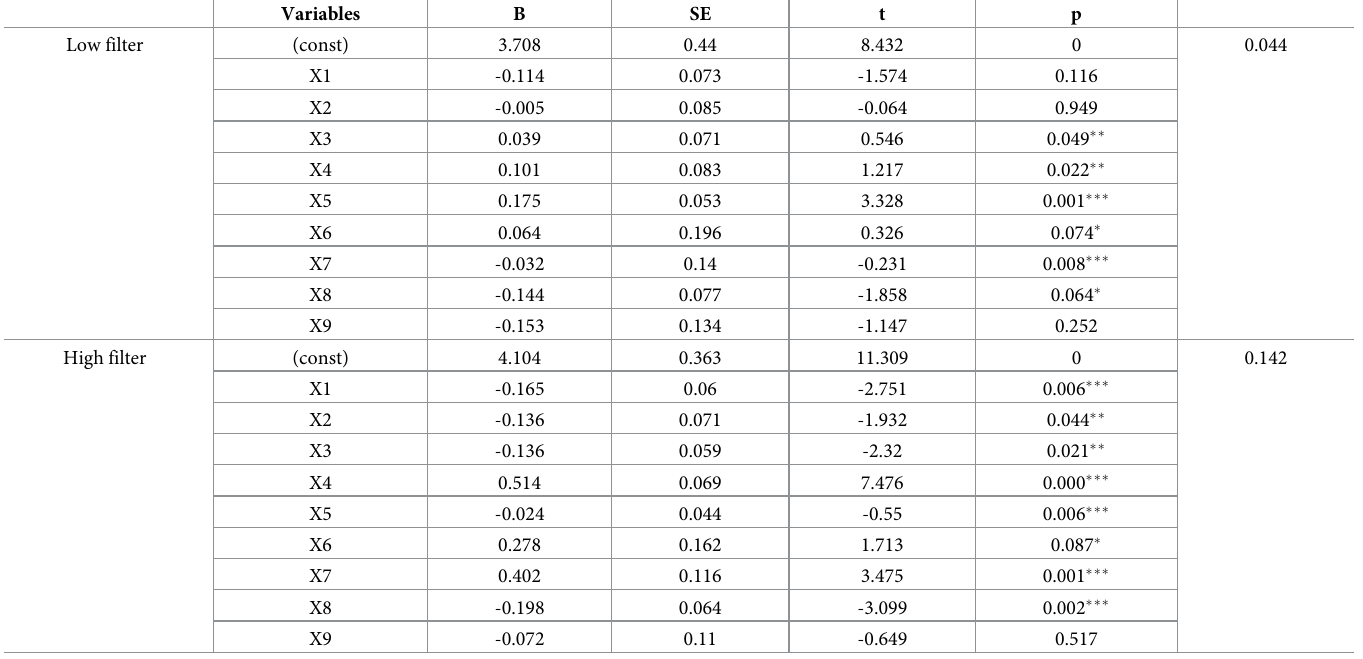
Table 6. Results of Chow verification for